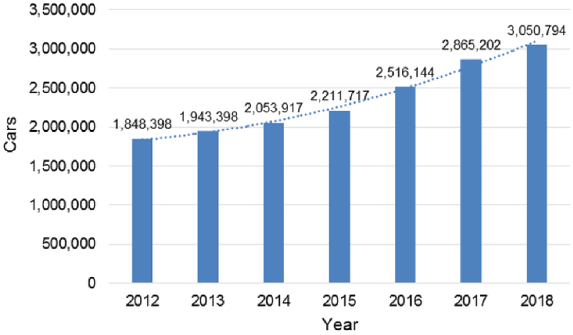
Figure 1: Growth of vehicles in Vietnam in the period 2012 – 2018